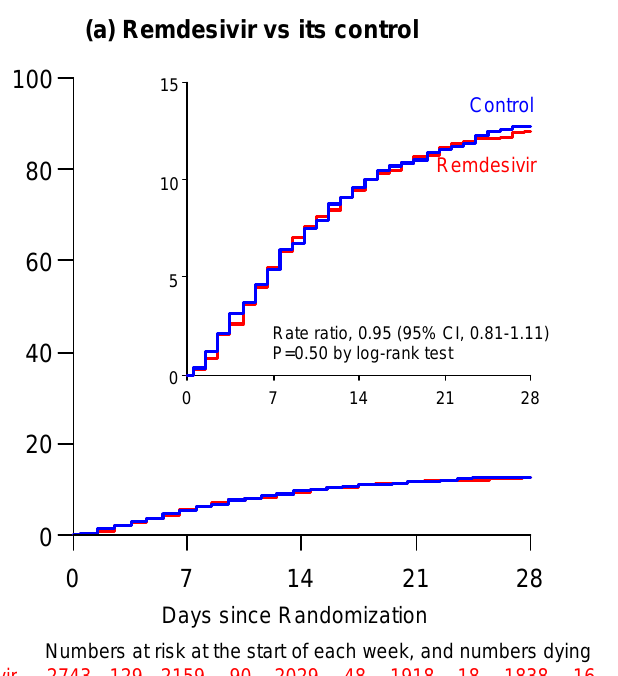
(c) Lopinavir vs its control